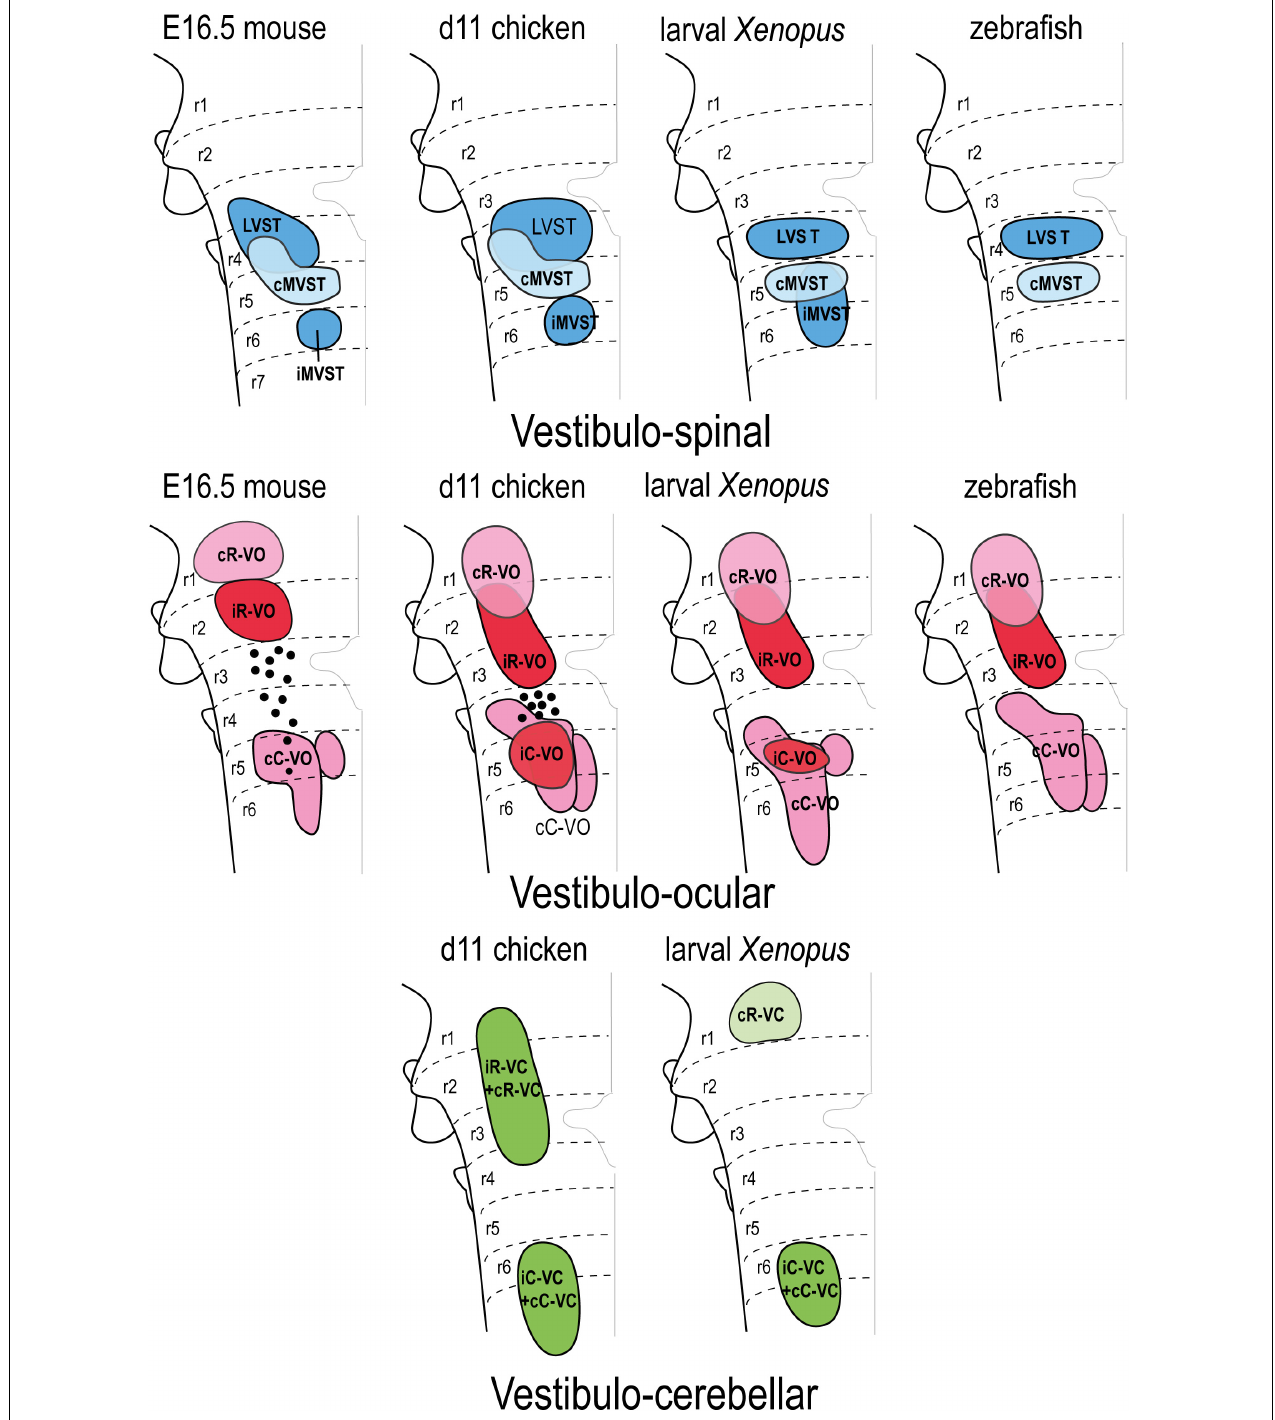
FIGURE 7 | Correlation of the pattern of the vestibular projection neuron groups with rhombomeres in the indicated amniote and anamniote species [reported data from Pétursdóttir (1990); Glover and Petursdottir (1991); Jansen (1991); Suwa et al. (1996); Díaz et al. (1998, 2003); Straka et al. (2001, 2002); Díaz and Puelles (2003); Pasqualetti et al. (2007); Di Bonito et al. (2015)]. Modified from Díaz and Puelles (2019) with permission. cC-VC, contralateral caudal vestibulo-cerebellar group; cC-VO, contralateral caudal vestibulo-ocular group; cMVST, contralateral medial vestibulo-spinal group; cR-VC, contralateral rostral vestibulo-cerebellar group; cR-VO, contralateral rostral vestibulo-ocular group; iC-VC, ipsilateral caudal vestibulocerebellar group; iC-VO, ipsilateral caudal vestibulo-ocular group; iMVST, ipsilateral vestibulo-spinal group; iR-VC, ipsilateral rostral vestibulocerebellar group; iR-VO, ipsilateral rostral vestibulo-ocular group; LVST, lateral vestibulo-spinal group; r,